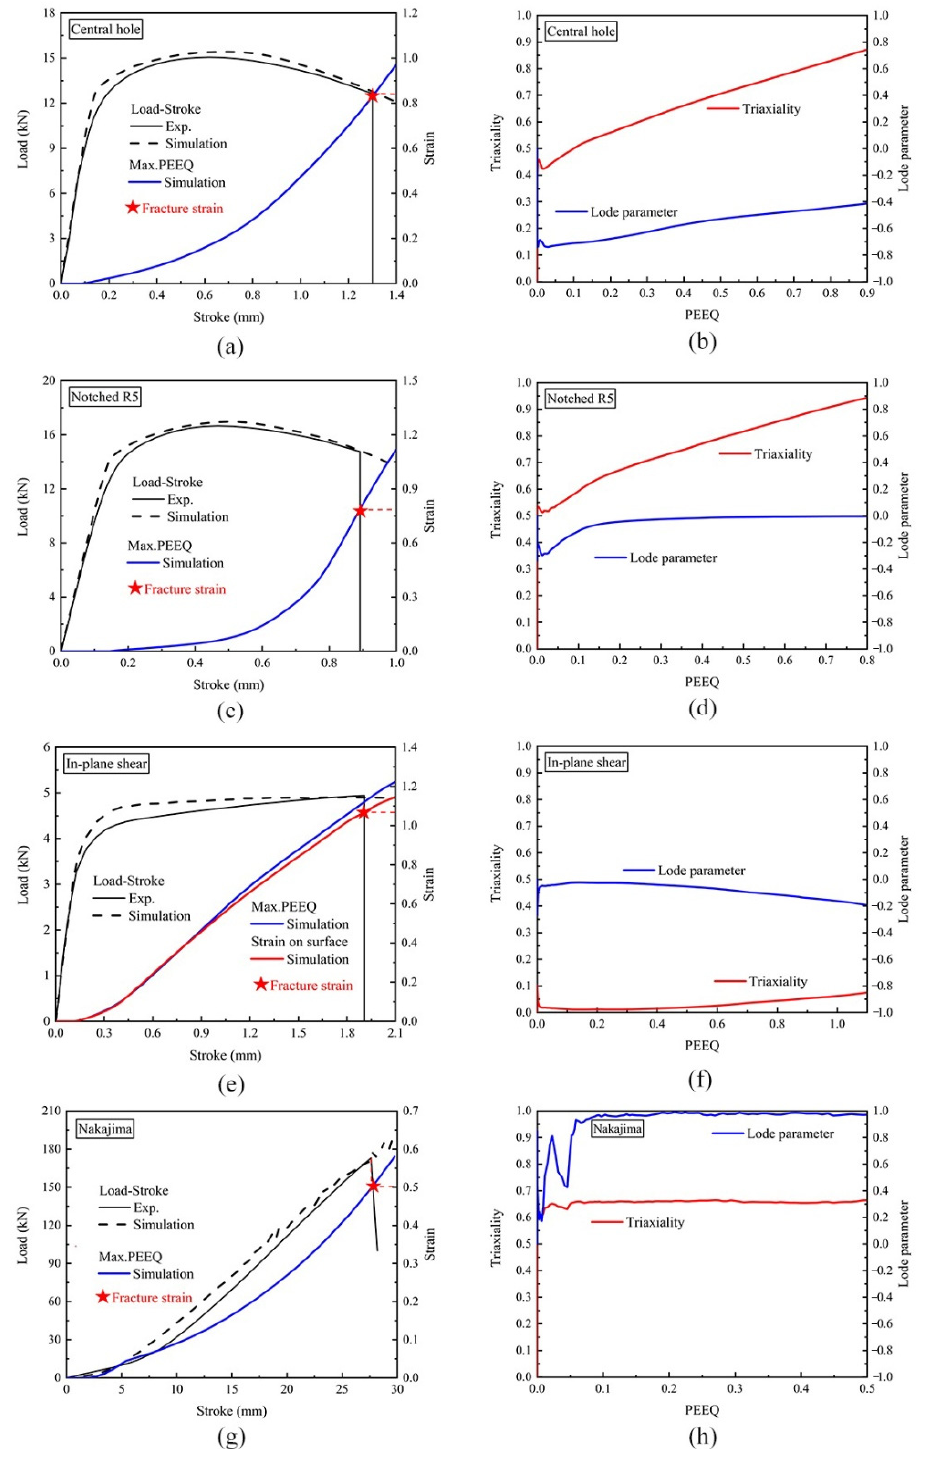
Figure A2. FE simulation results of tensile process for 80%B + 20%M specimens: ( a ) central hole, ( c ) notched, ( e ) in-plane shear, and ( g ) Nakajima specimen simulated load–stroke curves and PEEQ distribution, compared with experimental results; ( b ) central hole, ( d ) notched, ( f ) in-plane shear, and ( h ) Nakajima specimen calculated evolutions of the Lode parameter and the triaxiality towards PEEQ.